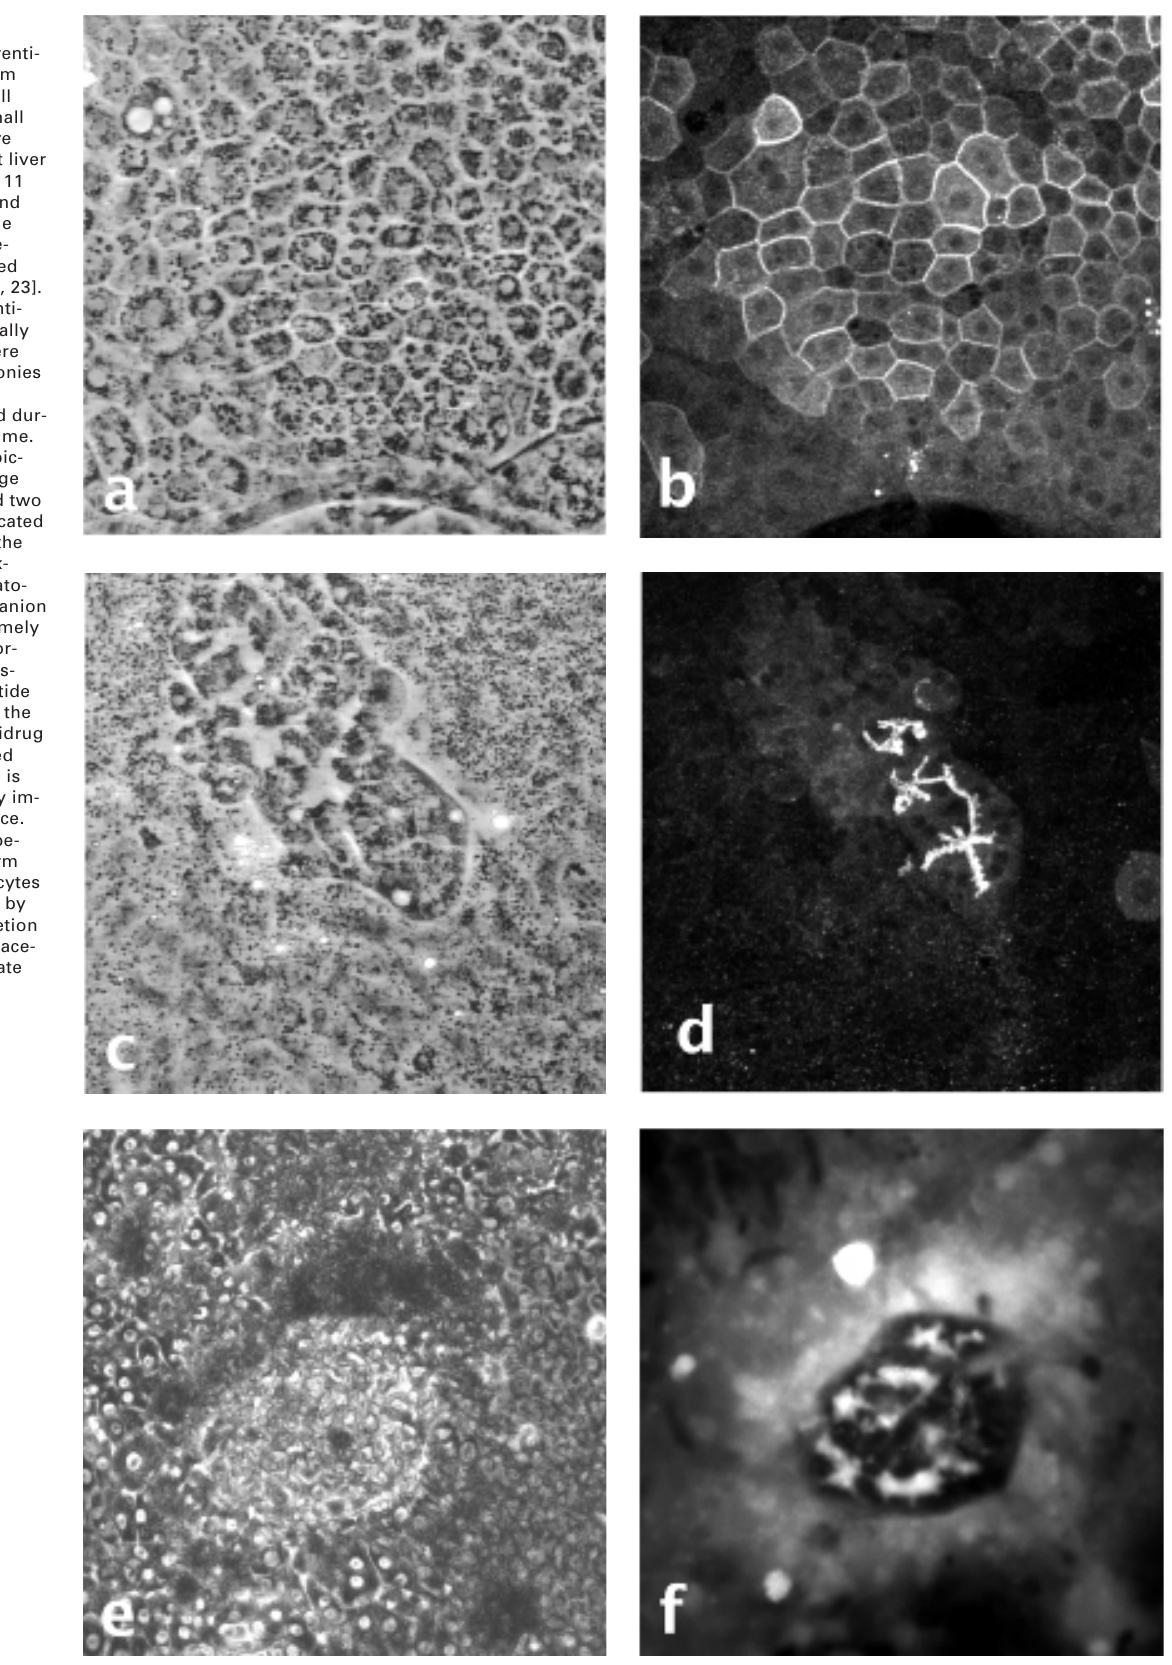
Figure 1 Functional differenti- ation of long-term cultured rat small hepatocytes. Small hepatocytes were isolated from rat liver and cultured for 11 (panels a to d) and 9 weeks (panels e and f) and subse- quently processed as described [22, 23]. Hepatocyte, identi- fied by hexagonally shaped cells, were observed as colonies of different size, which developed dur- ing the culture time. Phase contrast pic- tures show a large colony in (a) and two smaller ones, located in the centre of the pictures (c,e). Ex- pression of hepato- cellular organic anion transporters, namely the basolateral or- ganic anion trans- porting polypeptide Oatp1b2 (b) and the canalicular multidrug resistance-related protein Mrp2 (d) is demonstrated by im- munofluorescence. Functional compe- tence of long term cultured hepatocytes is demonstrated by canalicular secretion of fluorescein-diace- tate (f), a substrate for